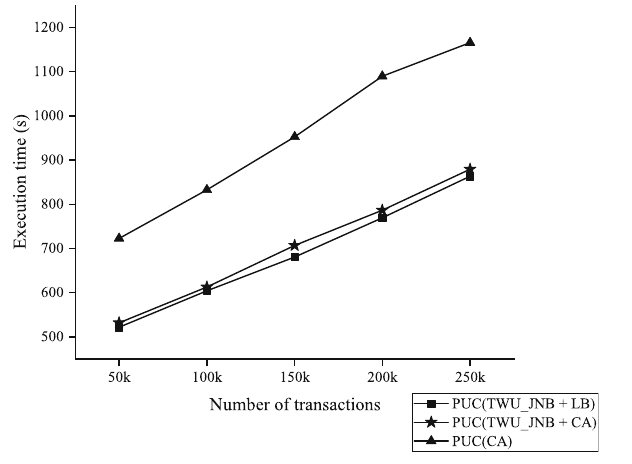
Figure 7: Comparison of PUC variants with PHUI - Growth.